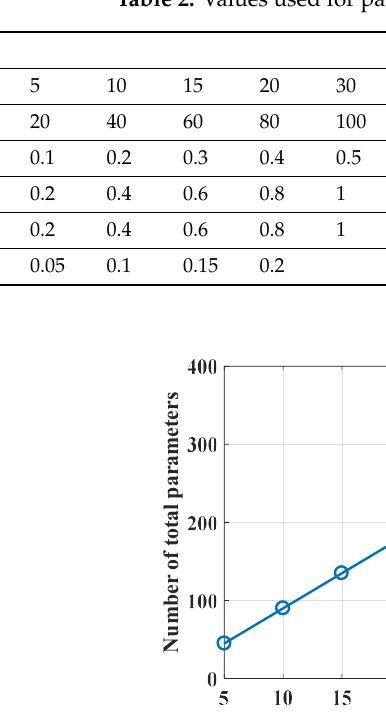
Table 2. Values used for parameters in parametric studies.